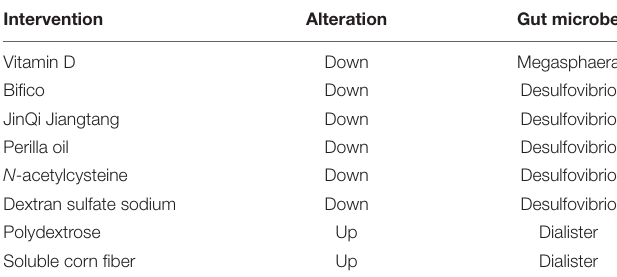
TABLE 3 | The gut microbes associated with AMI have the opposite pattern of change with interventions searched in the gutMDisoeder